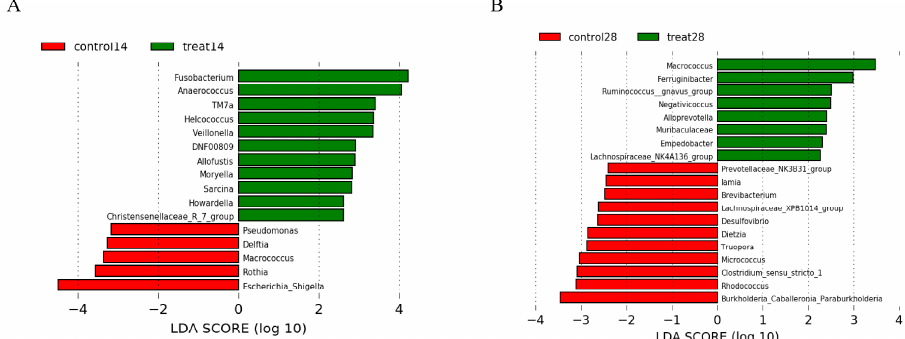
Figure 8. Effects of dietary supplementation with MSFAs on vaginal microbial diversity and com- position of sows at 14 and 28 days of gestation. Linear discriminant analysis coupled with effect size (Lefse) of day 14 ( A ) and day 28 ( B ) vaginal microbiota composition of control and treated sows. Control14 (28), day 14 (28) of gestation and fed the basal diet. Treat14 (28), day 14 (28) of gestation and fed a basal diet supplemented with 0.1 SB, 0.05 SC and 0.1% SL.